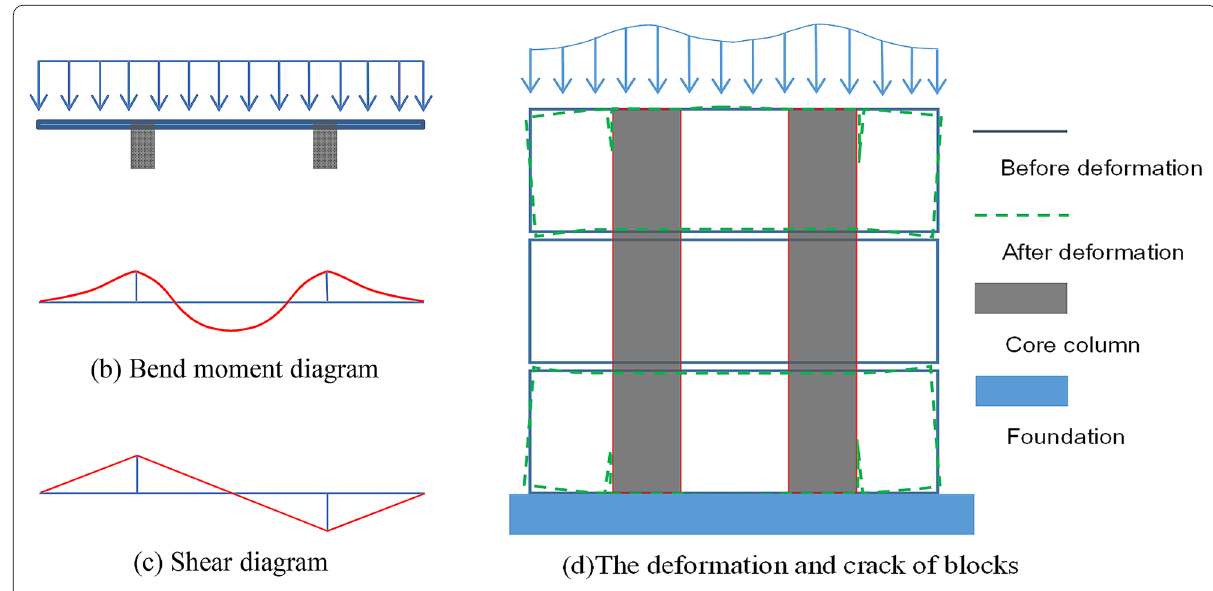
Fig. 7 Force mechanism of the compression